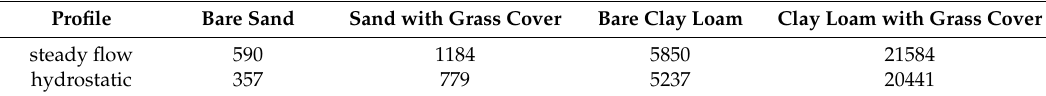
Table 4. Estimates of travel time (days) for steady flow and hydrostatic θ profiles.